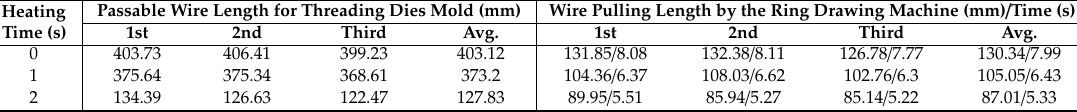
Table 20. Results based on wire pulling speed: k9(16.32 mm / s).